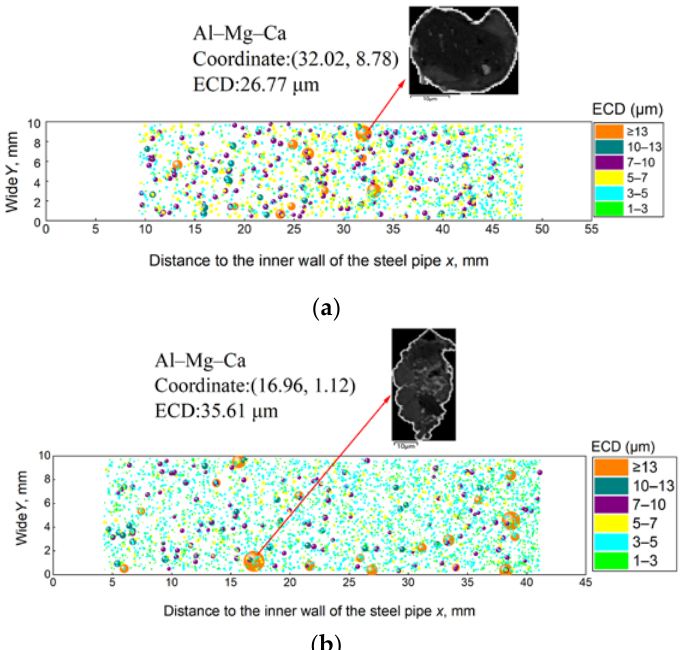
Figure 3. Original statistical distribution of non-metallic spherical oxide inclusions based on ECD in ( a ) sample 1# and ( b ) sample